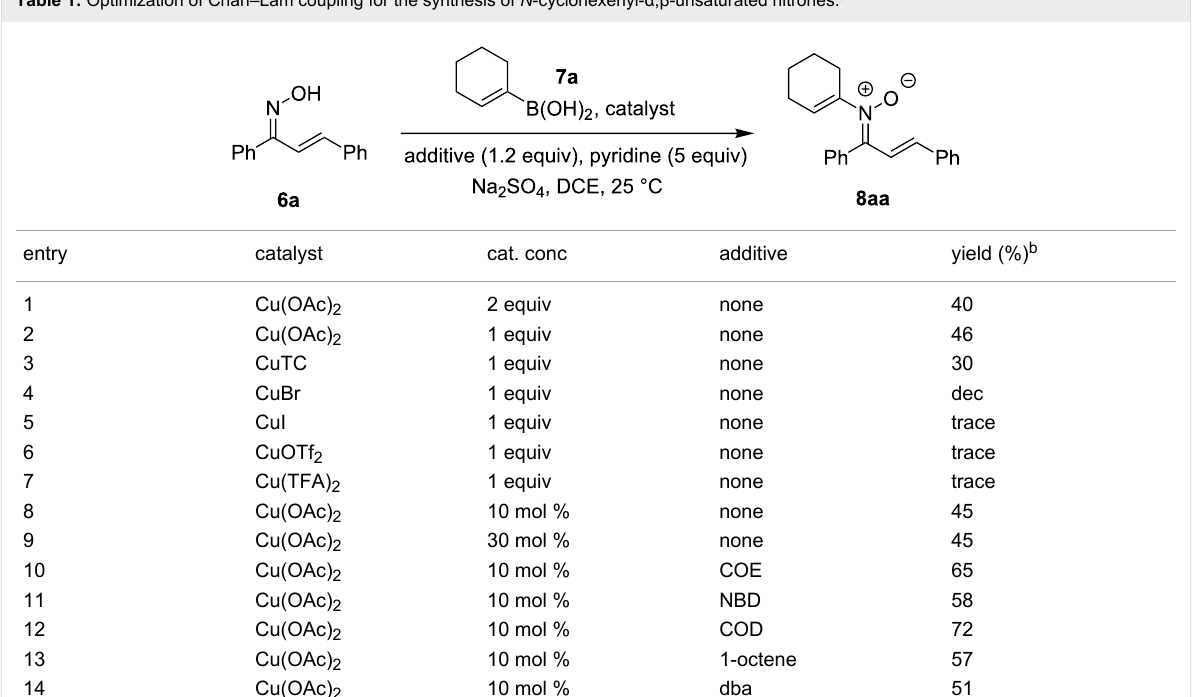
Table 1: Optimization of Chan–Lam coupling for the synthesis of N -cyclohexenyl- α , β -unsaturated nitrones.